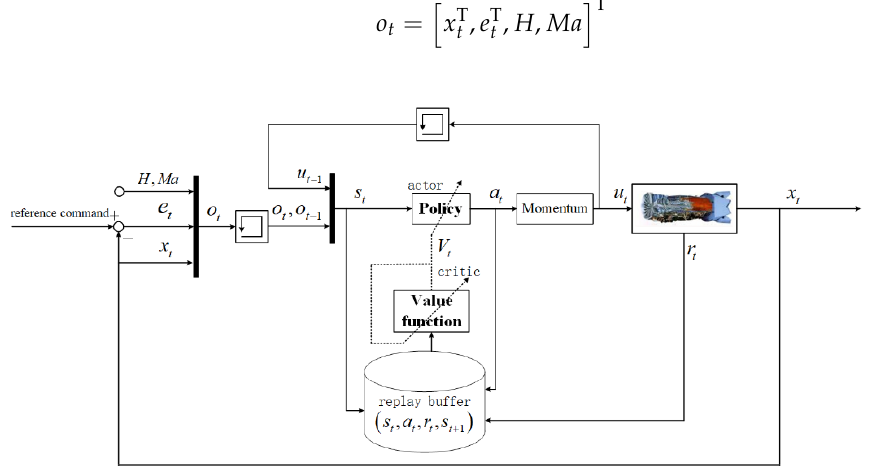
Figure 3. The aero-engine control system with deep reinforcement learning.